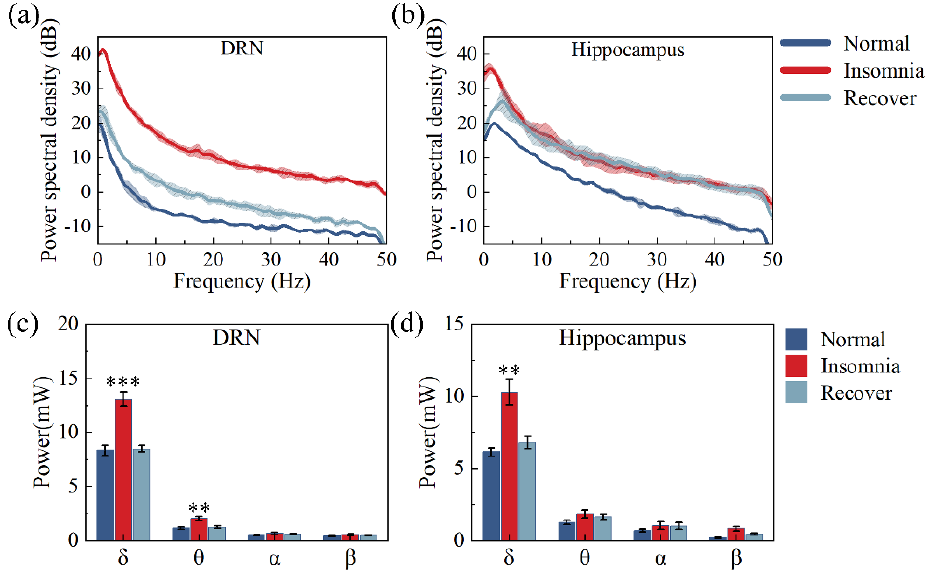
Figure 8. Statistics for PSD and power of rats’ dorsal raphe nucleus (DRN) and hippocampus of rats in normal, insomnia and recovery states ( n = 12). ( a ) PSD statistics in DRN; ( b ) PSD statistics in hippocampus; ( c ) Power statistics in the DRN; ( d ) Power statistics in the hippocampus. δ : 0–4 Hz; θ : 4–7 Hz; α : 8–12 Hz; β : 13–30 Hz. (** p < 0.01, *** p < 0.001, compared to normal in the same brain region).